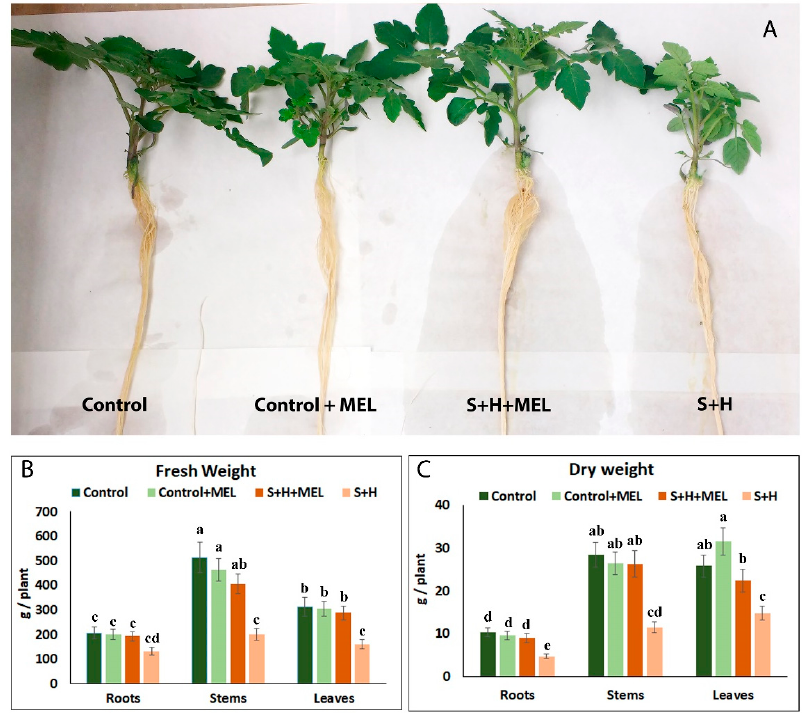
Figure 1. ( A ) Pictures of the tomato plants at the end of the different treatments; Fresh ( B ) and dry weight ( C ) obtained from roots, stems and leaves of tomato plants grown under control conditions or stress combination (salinity and heat, S + H) with (+MEL) or without melatonin pre-treatment. Values represent means ± SE ( n = 6). Bars with different letters within each panel are significantly different at p > 0.05 according to Tukey’s test.